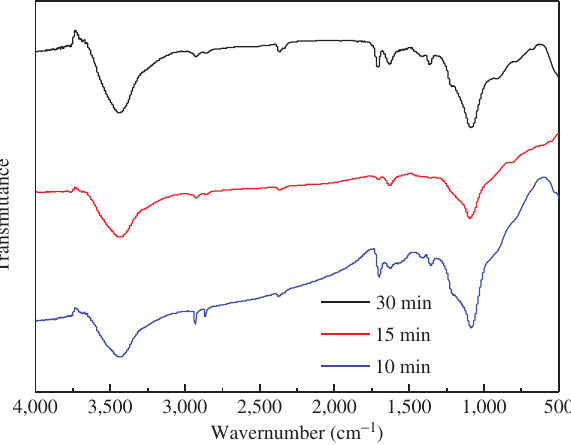
Figure 7: FTIR spectra of activated carbon at different microwave heating times from waste bamboo.